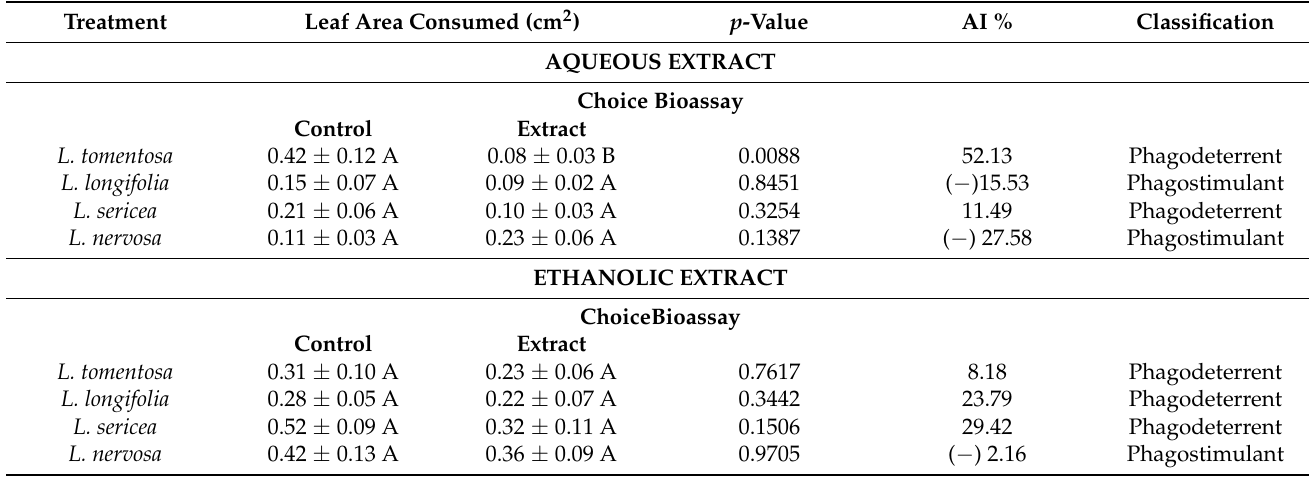
Table 1. Leaf area consumed by Plutella xylostella larvae and antifeedant index (AI) values resulting from aqueous extracts of Ludwigia spp. after food exposure.